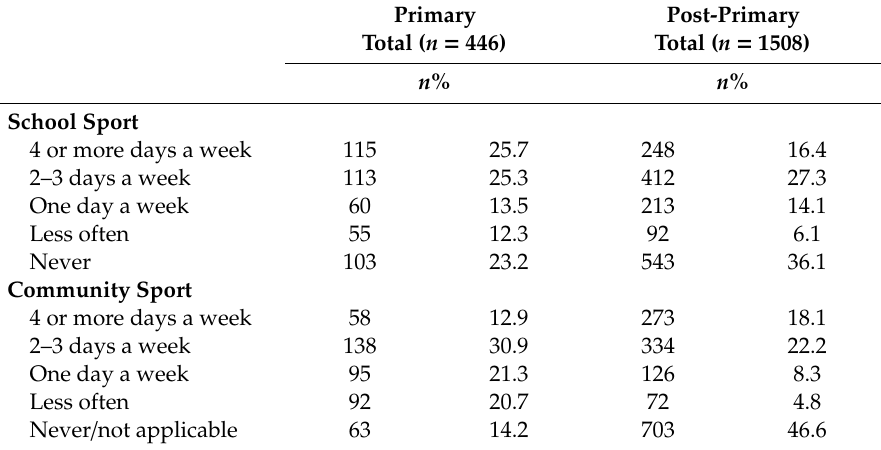
Table 6. Frequency of school sport and community sport participation for primary and post-primary school pupils.